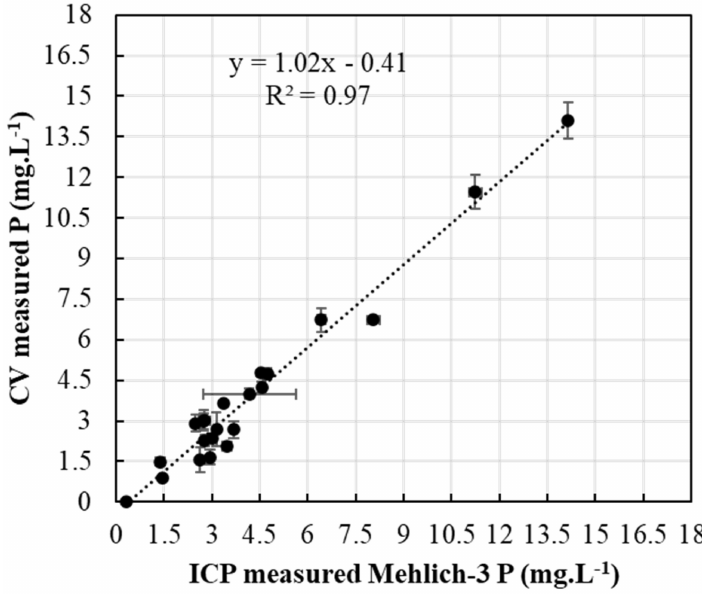
Figure 8. Measured CV (using ERR IFP) soil P versus ICP Mehlich-3 soil